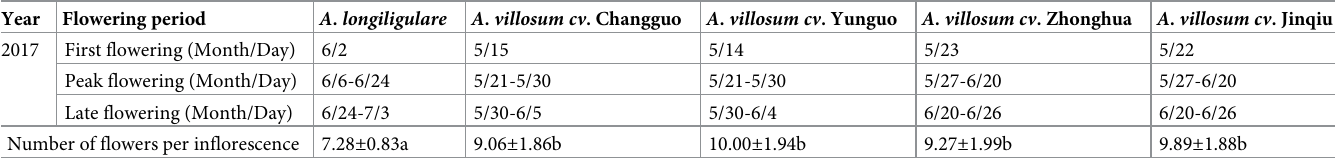
Table 1. Comparison of flowering phenology of 5 herbaceous Amomum germplasms.